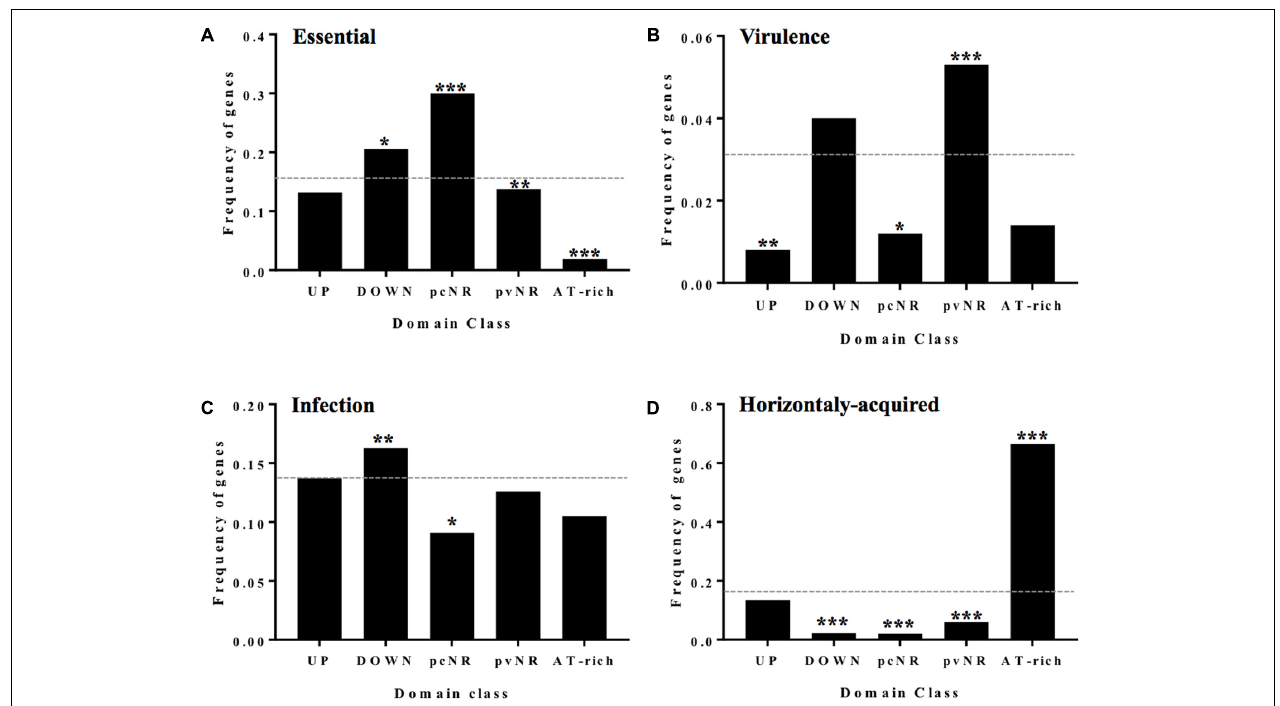
FIGURE 12 | Genes of the different domains have different functionalities. (A) Fraction of essential genes in different domains. (B) Virulence factors. (C) Horizontally acquired genes abundance and domain class. (D) Essential genes for infection by STM. Statistical significance with respect to the genome average (dashed